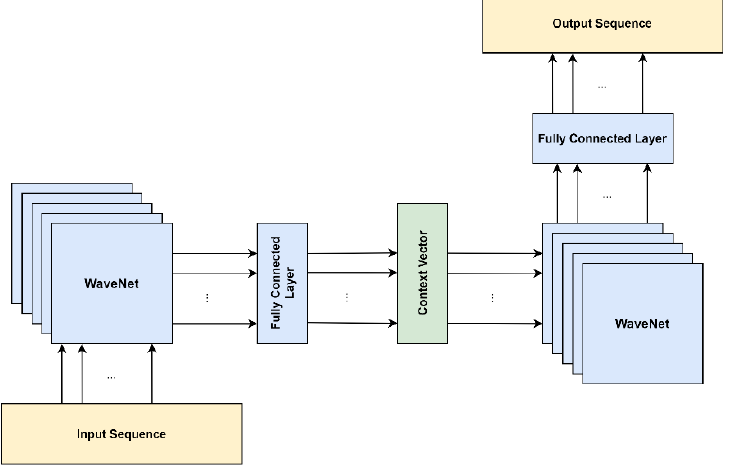
Figure 2. Generic scheme of the proposed